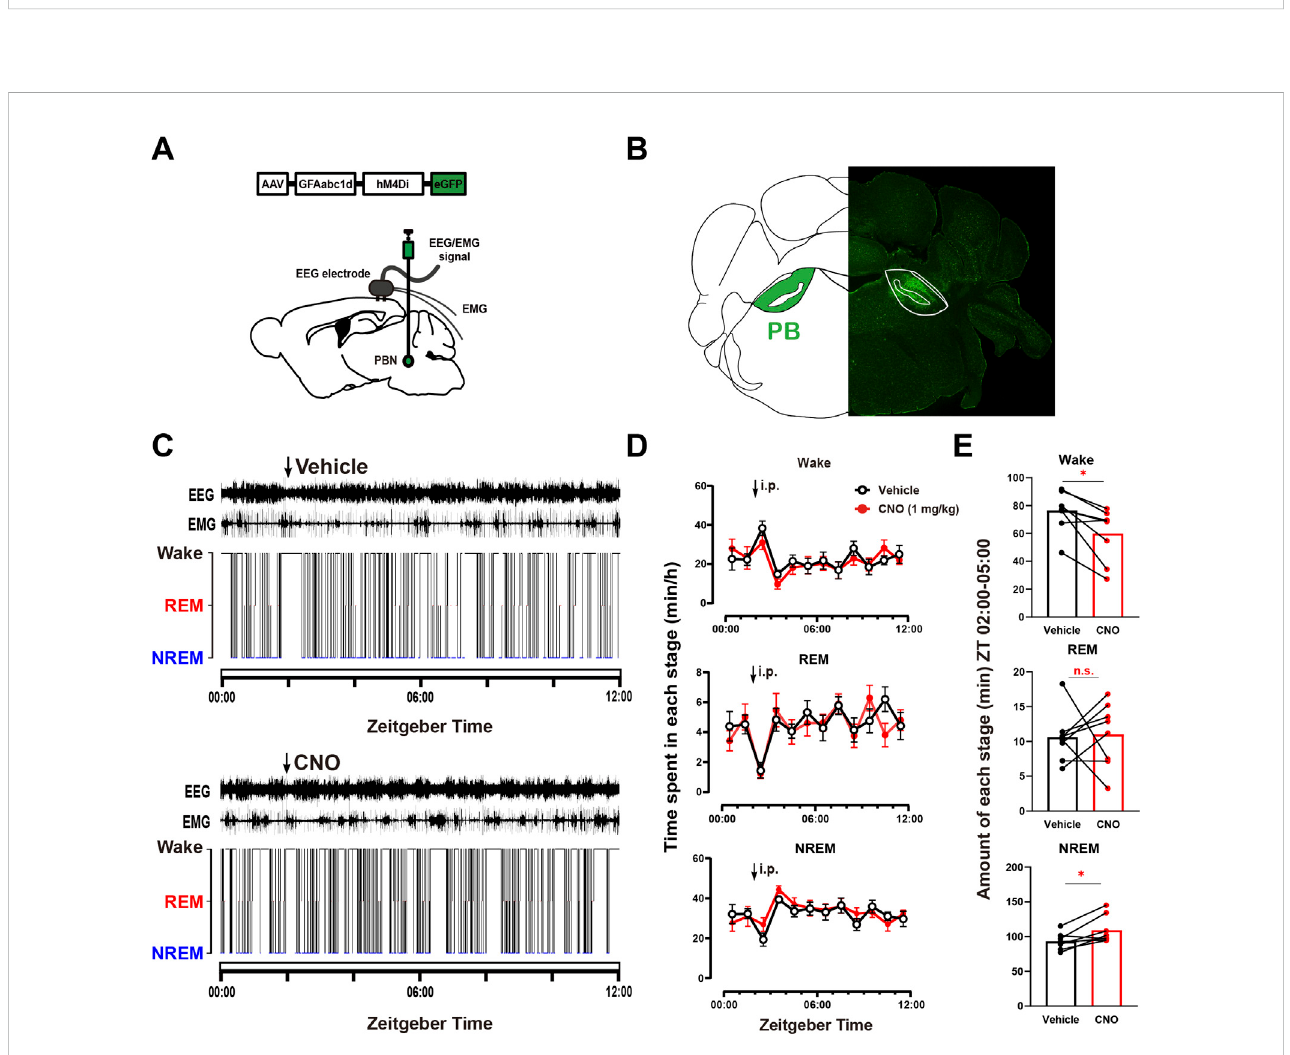
FIGURE 2 Chemogenetic inhibition of PBN astrocytes decreases total wakefulness (A) Schematic diagram showing the bilateral injection of AAV-GFAabc1d- hM4Di-eGFP into the PBN of mice. The EEG electrodes were screwed into the craniotomy hole, and the EMG electrodes were bilaterally placed into the trapezius muscles. (B) Representative fl uorescent image showing the expression of AAV-GFAabc1d-hM4Di-eGFP in the PBN. (C) Typical examples of EEG/ EMG traces and corresponding hypnograms from one hM4Di mouse which was intraperitoneally injected with vehicle (top) or CNO (1 mg/kg, bottom) successively at ZT 02:00. CNO injection was performed 24 h after vehicle injection. (D) Time course of wakefulness, REM sleep, and NREM sleep after intraperitonealinjectionofvehicleor1 mg/kgCNOinhM4Dimice. Two-wayrepeated-measuresANOVA( n =8). (E) Totaltime spentineachstageduringthe 3-h post-injection period (ZT 02:00 – 05:00) in hM4Di mice. Paired t -test ( n = 8). Values represent the mean ± SEM; * p < .05 shows signi fi cant differences between the vehicle and experimental groups. PBN, parabrachial nucleus; CNO, clozapine N-oxide; i.p., intraperitoneal